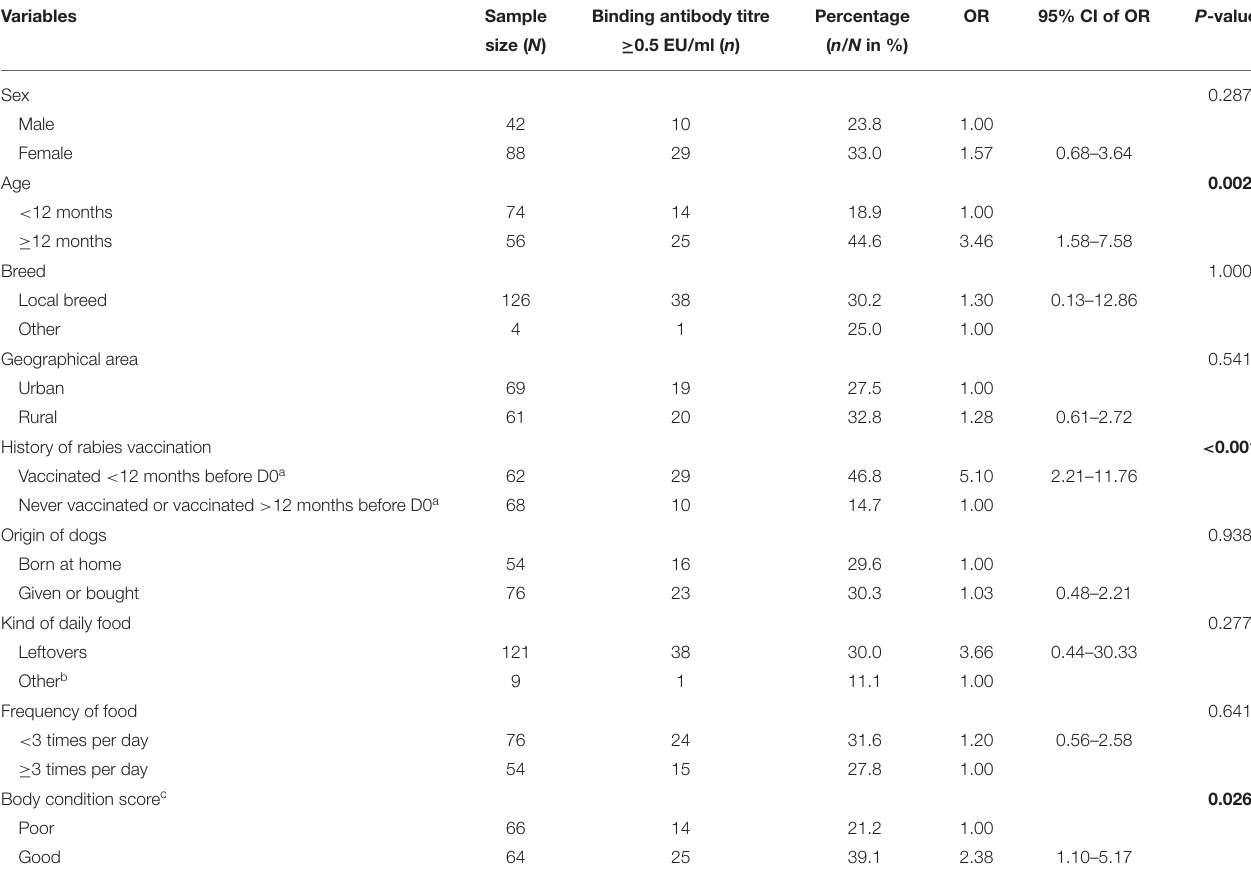
TABLE 2 | Frequency ( n ) and percentage ( n / N ) of dogs having a level of ≥ 0.5 EU/ml of binding antibodies at D0, stratified by different demographic characteristics of the dogs.